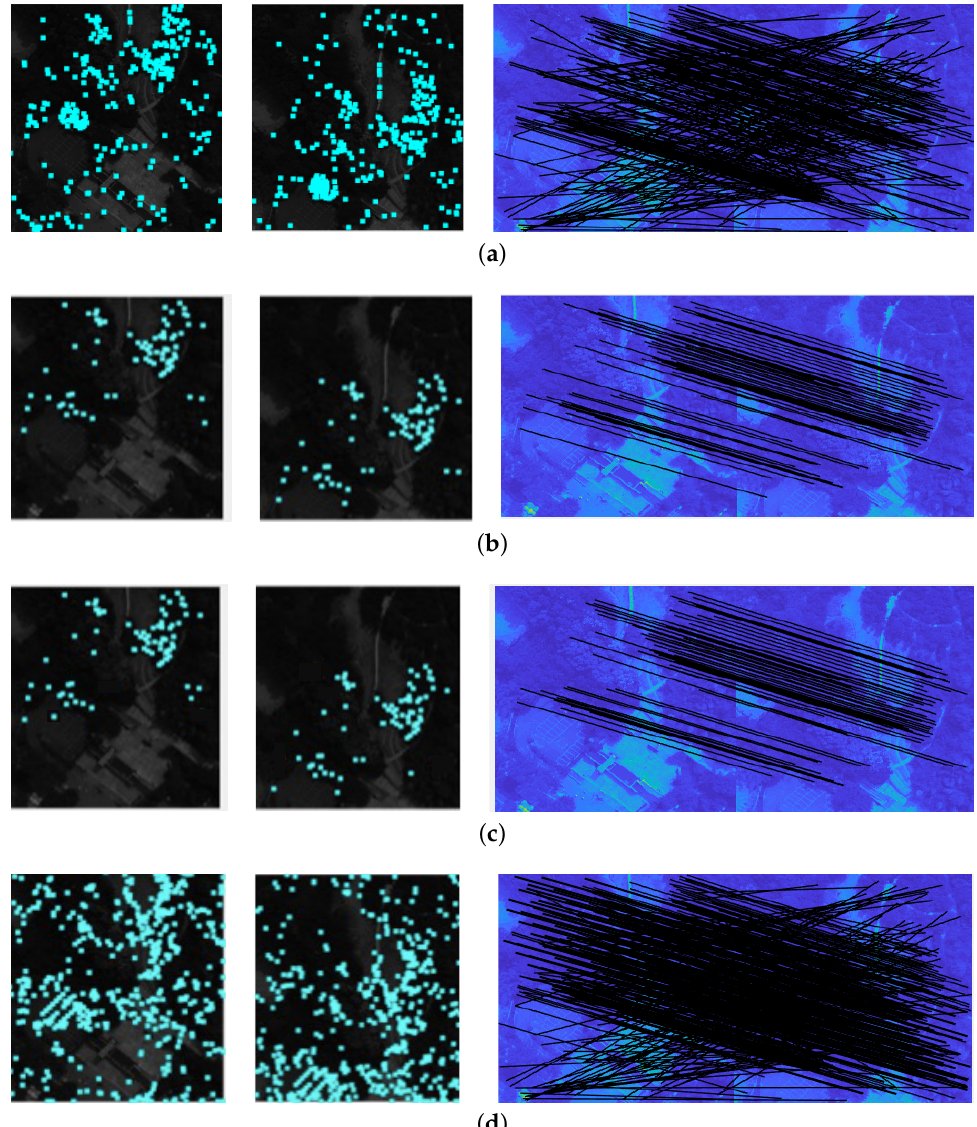
Figure 4. Feature point detection and matching of SIFT [14], SURF [8], KAZE [37] and SuperPoint [31]: 1275 future points and 754 tentative matches by SIFT [14], 275 future points and 132 tentative matches by SURF [8], 281 future points and 154 tentative matches by KAZE [8], 2246 future points and 1756 tentative matches by SuperPoint [31]. ( a ) SIFT; ( b ) SURF; ( c ) KAZE; ( d )